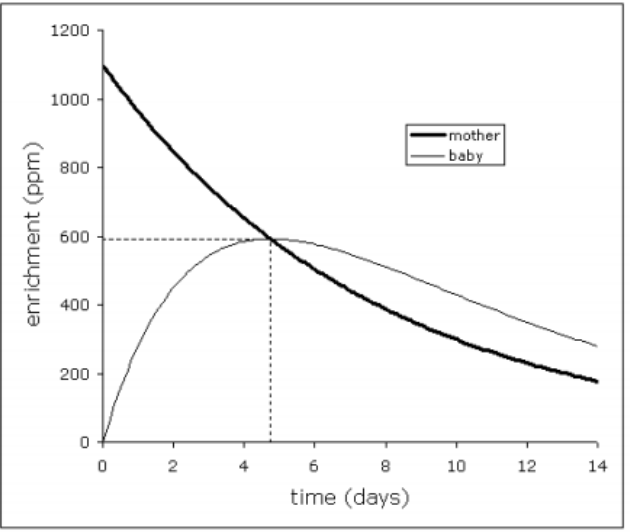
Figure 3. Isotope enrichment of mother’s and infant’s total body water for an exclusively BF infant (representative example pattern) .